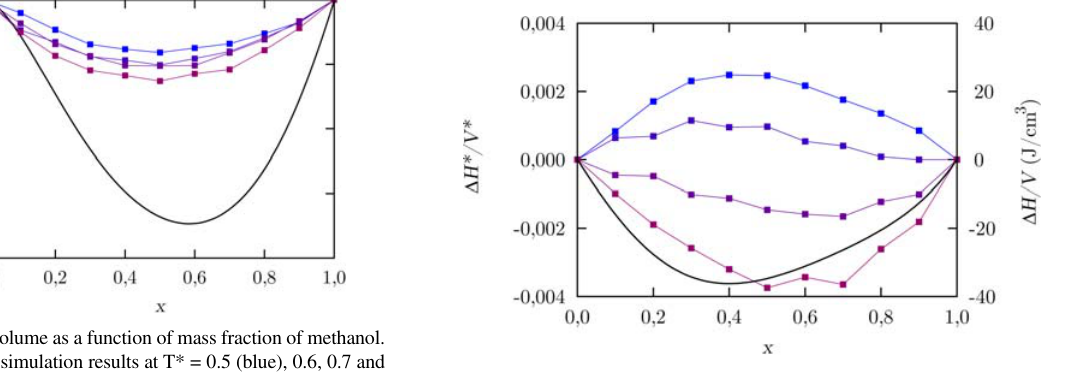
Figure 7: Excess enthalpy of mixing as a function of mass fraction of methanol. Legend as in Figure